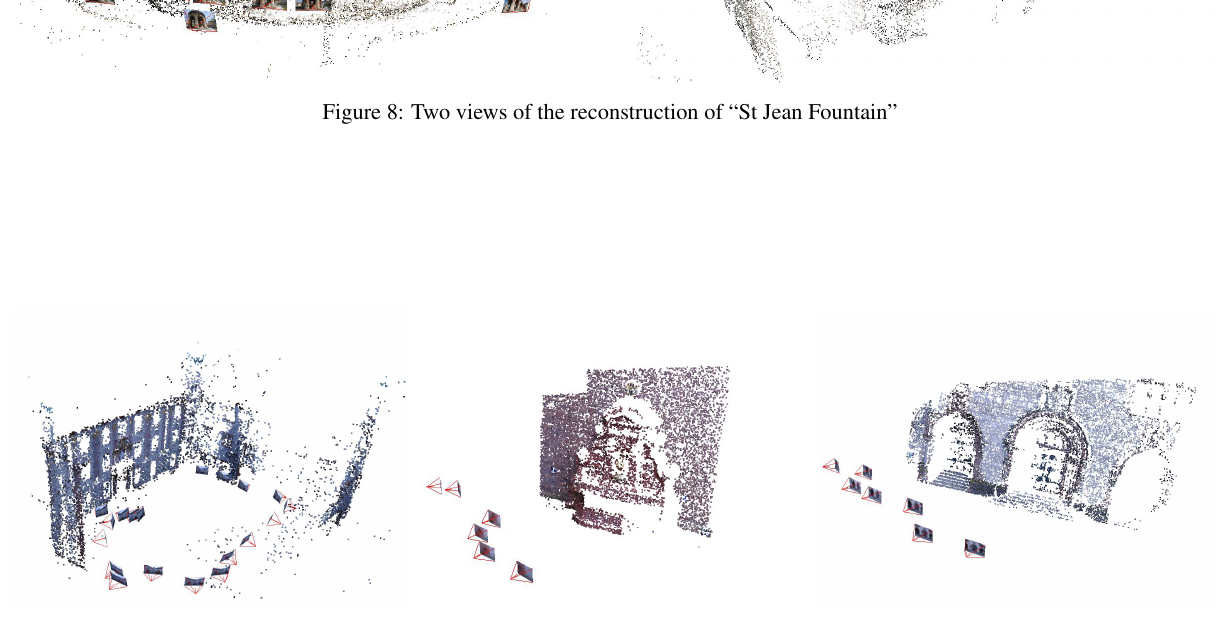
Figure 9: Reconstruction of “Castle-K19”, “Fountain-K6”, and